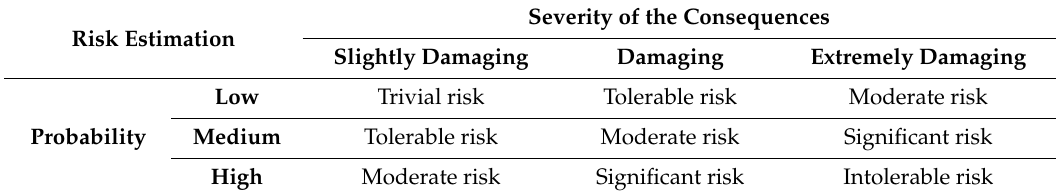
Table 3. Risk estimation. Qualitative values.